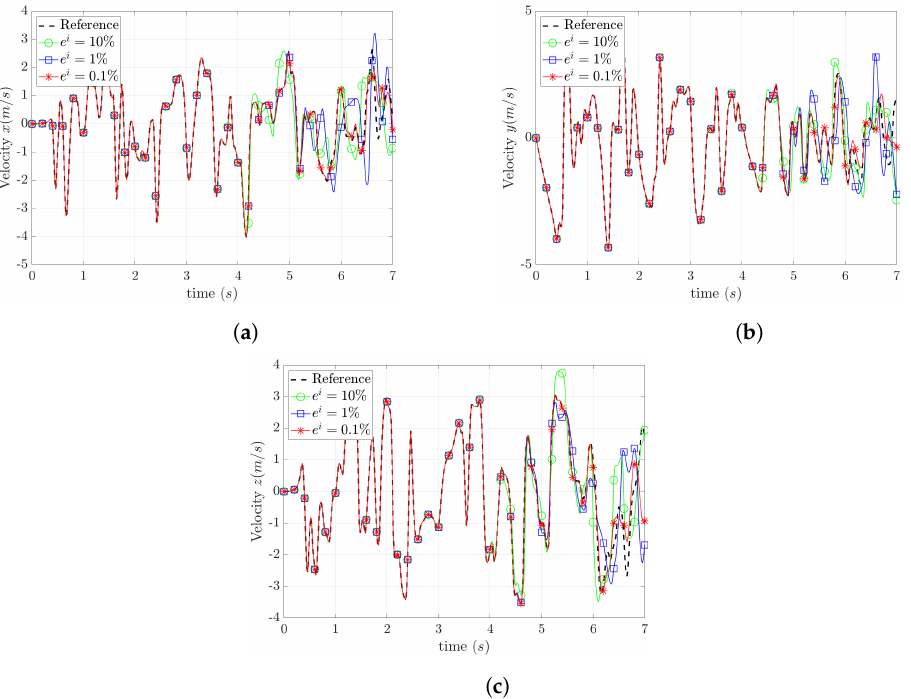
Figure 6. The x , y , and z velocities of node A for the error tolerance e i = 10%,1%, and 0.1%. ( a ) Velocity x of node A ; ( b ) velocity y of node A ; ( c ) velocity z of node A .